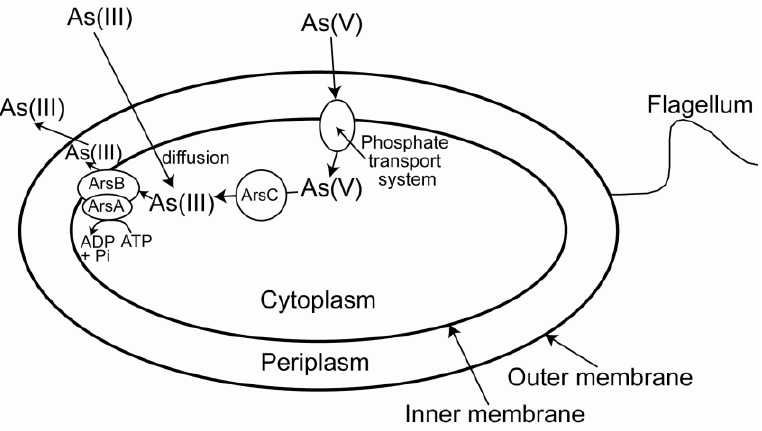
Figure 2. Conceptual diagram of the bacterial arsenic resistance mechanism. See text for explanation.